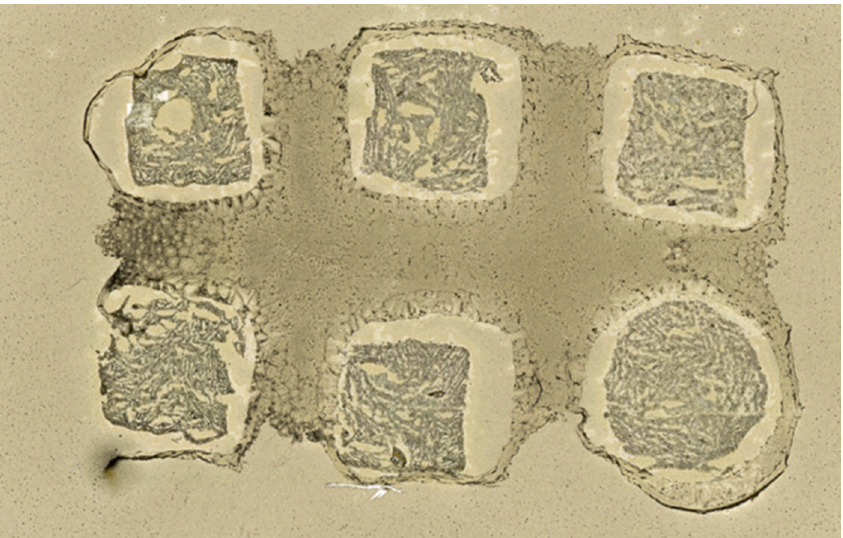
Figure 2. Representative section of tissue mimetic model. Samples are relatively homogenous, though the difference in shrinkage between the homogenate and gelatin causes it to separate after transfer to the slide.